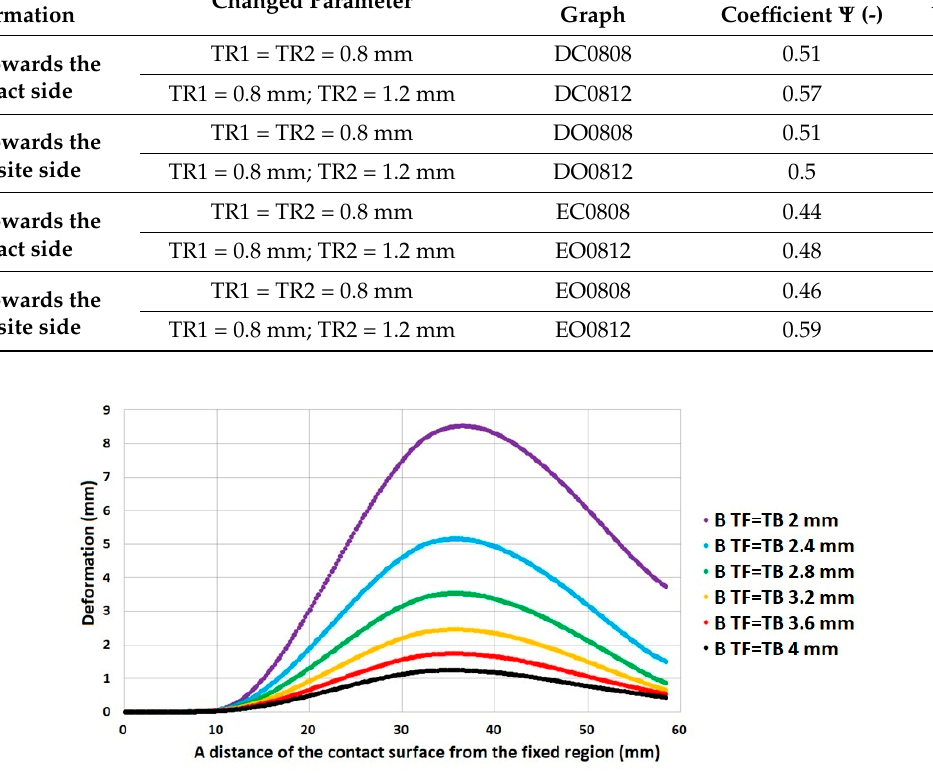
Figure 10. Fingers’ contact side deformation of the variants of structures B under load 5 N.